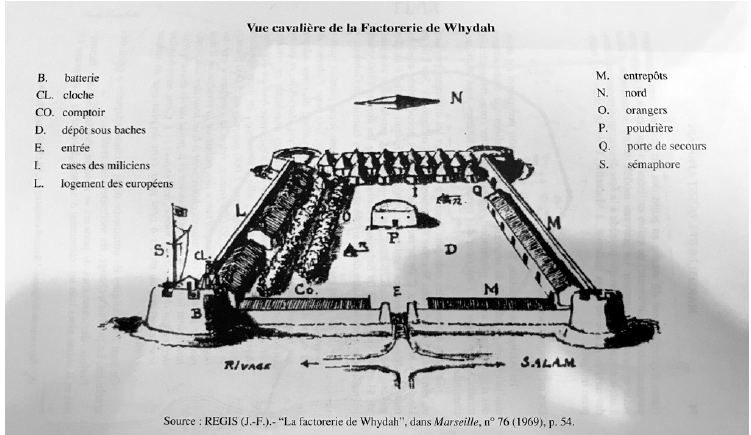
Figure 9. A drawing of the Fort in Ouidah by Jean-François Régis, grandfather of Helen Regis, from his self-published family history. Image courtesy of the Regis family.